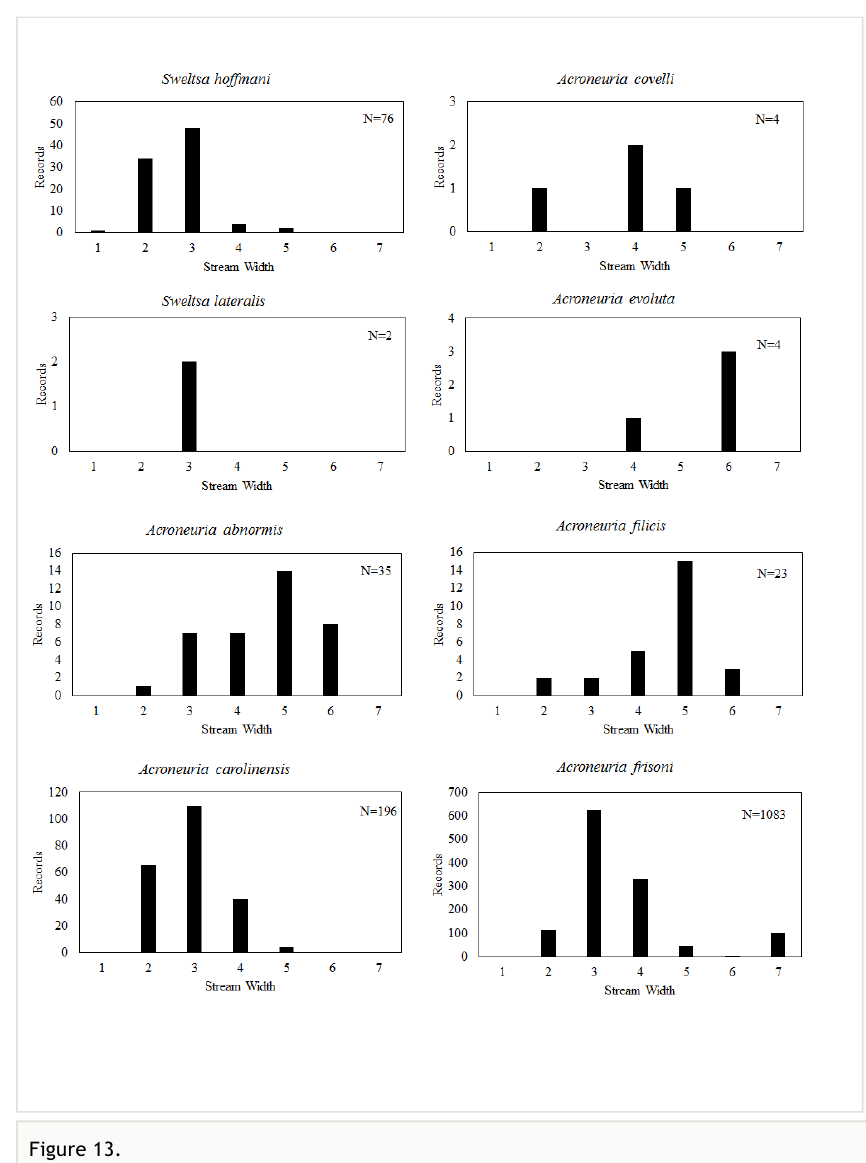
Figure 13. Stream width categories occupied by Chloroperlidae and Perlidae species in Ohio. Stream width categories: 1=seep, 2=1-2 m, 3=3-10 m, 4=11=30 m, 5=31-60 m, 6=>60 m, 7=Lake